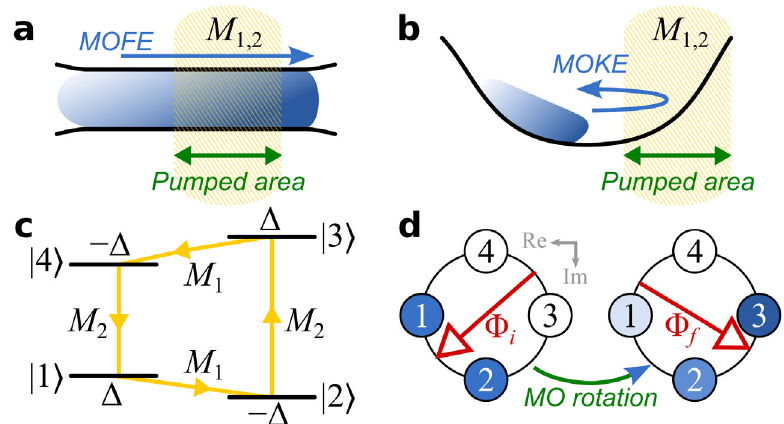
Fig. 1 Illustration of the model setups. The atomic current (emulated light) is prepared by ( a ) the transport in a channel or ( b ) the mechanical oscillation within a harmonic trapped potential. When entering the pumped area (yellow hatched area, the emulated medium), atomic pseudo-spin states are coupled by optical fi elds M 1,2 . c Transitions between pseudo-spin states driven alternately by the optical fi elds M 1 and M 2 . The pseudo-spin states are labeled by j j i ( j = 1, 2, 3, 4) that simultaneously characterizes the position in the synthetic dimension. d The polarized angle Φ (red arrows) for the emulated light is de fi ned by the COM coordinate in the synthetic ring lattice (constructed by the pseudo-spin states labeled by numbers). After the emulated light passes through or is re fl ected by the emulated medium, MOFE or MOKE occurs if the initial polarized angle Φ i is rotated to the fi nal one Φ f . The MO rotation is detected by the occupation in each pseudo-spin state (characterized by the blue color). We use the subscripts i and f as the denotations of the initial and fi nal